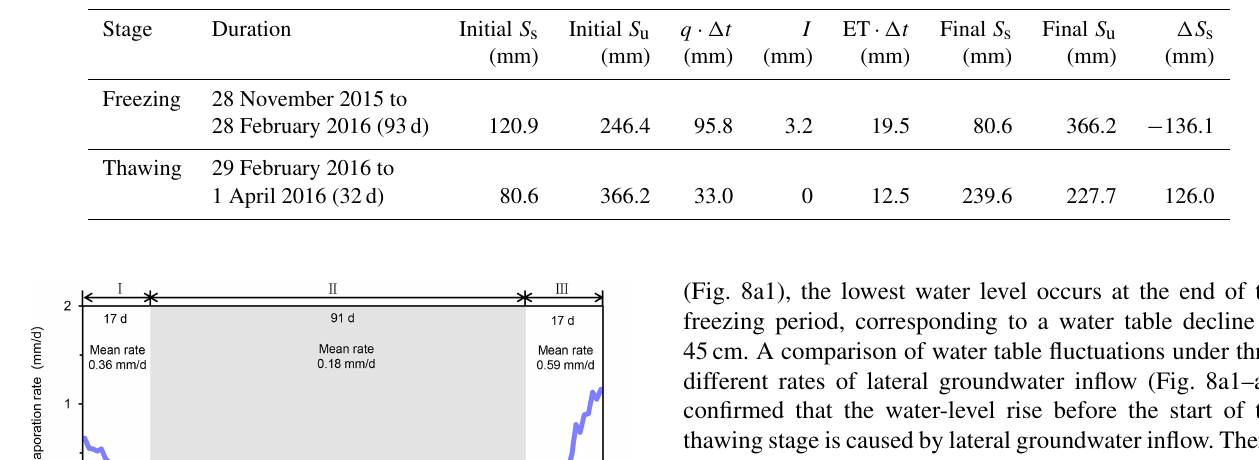
Table 3. Water budgets during the freezing–thawing cycle.